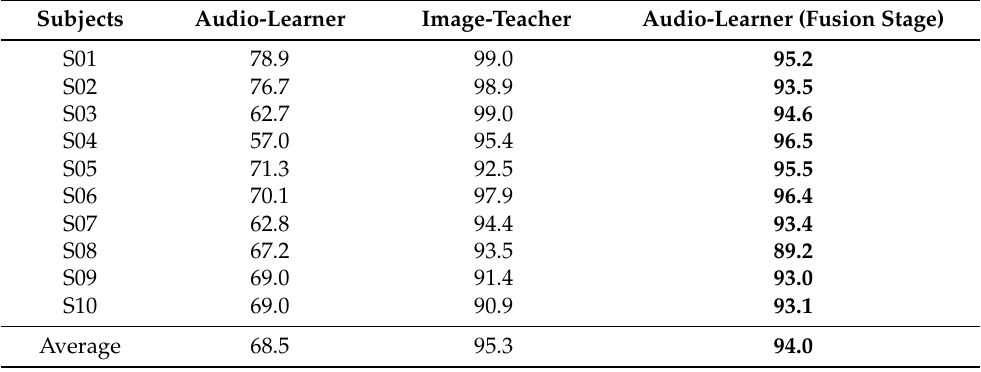
Table 12. Comparison of the average classification accuracy (expressed in percentage) of the perfor- mance achieved when the audio-learner model is trained over TL-FmRADLs against the baseline performance of the image-teacher